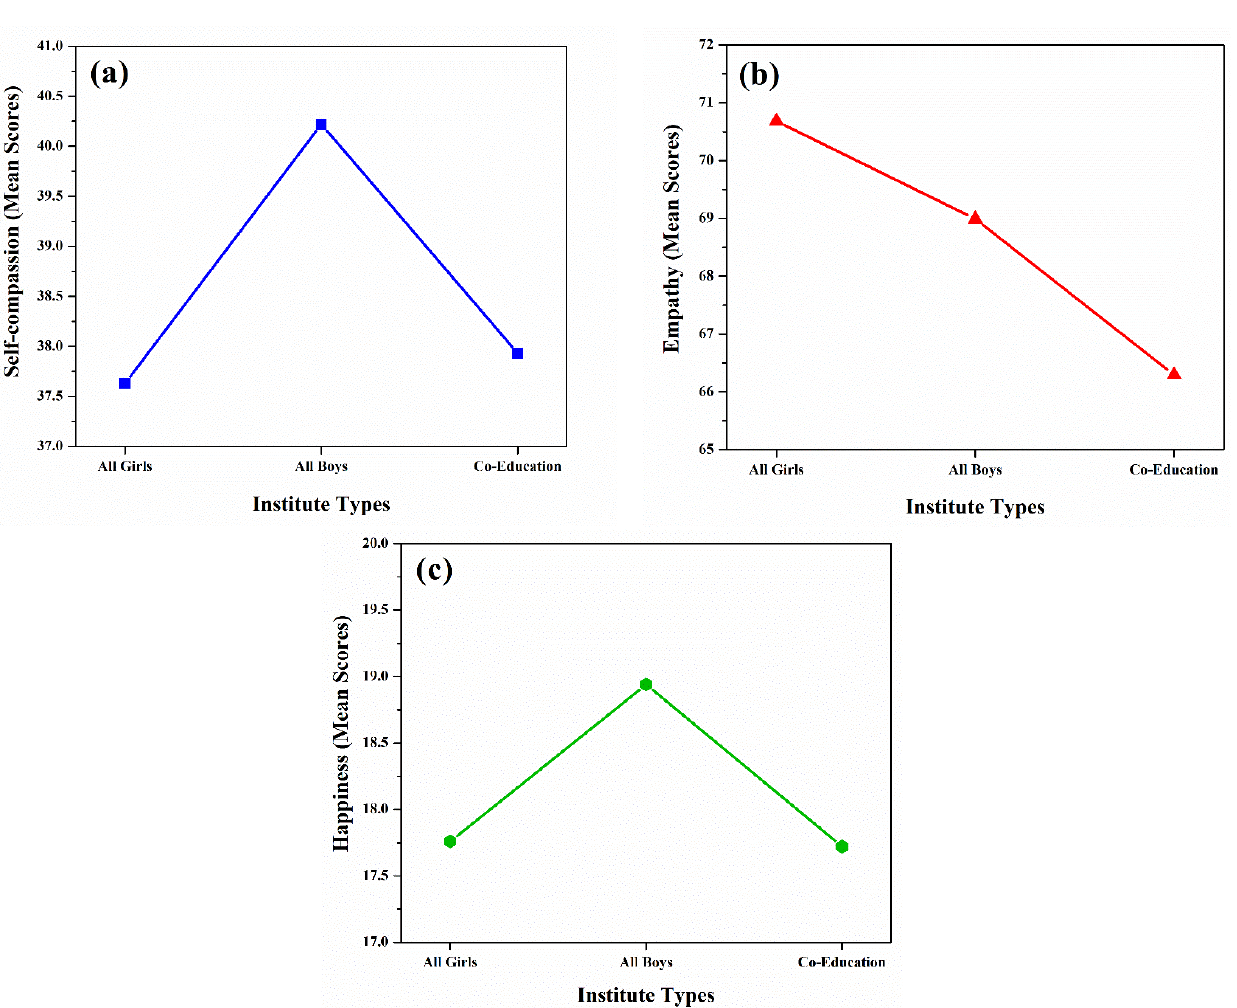
Figure 5. Comparison of ( a ) self-compassion, ( b ) empathy, and ( c ) happiness among adolescents from different types of institutes.